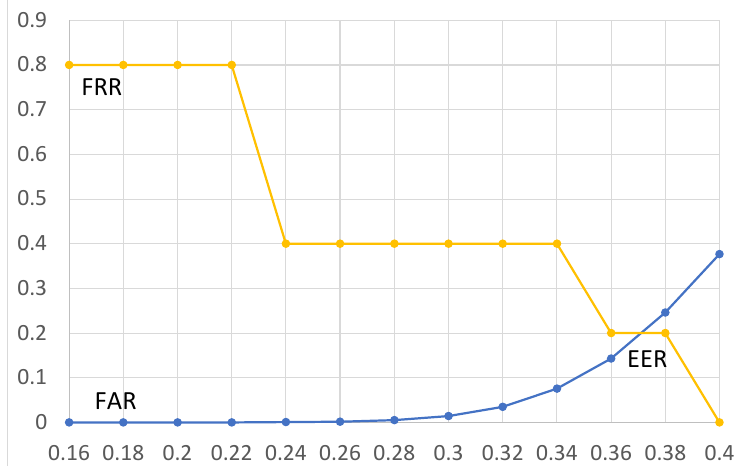
Figure 8. EER for re-sampling manipulation. The X-axis represents the threshold (0–1), and the y-axis represents the error rate (0–100).